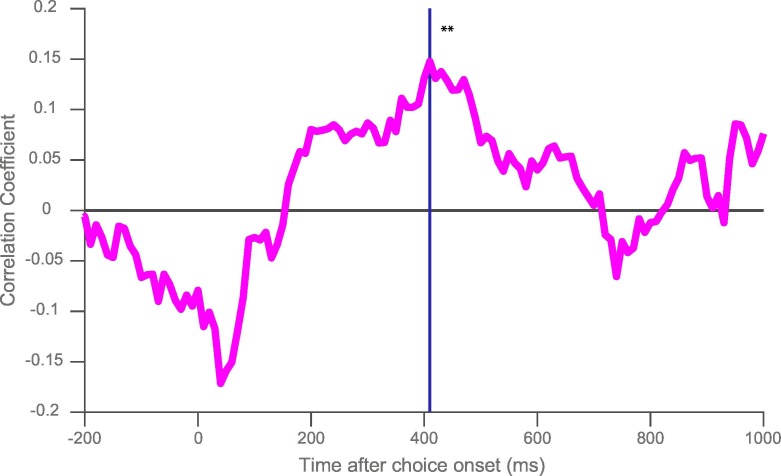
Rank correlation between resting time constant and chosen value correlates during the decision phase.At the time of maximum population-average chosen value coding (indicated by the blue line), there is a positive correlation between time constant and the coefficient of partial determination (CPD) for chosen value (correlation coefficient = 0.148; p=0.0018). ** represents p<0.01.